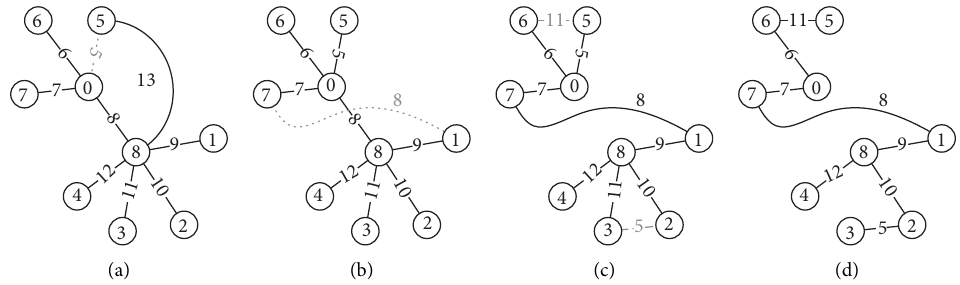
Figure 4: (a) A caterpillar with a strongly c-elegant labelling with [ 6 , 13 ] . (b) A caterpillar T with a strongly c-elegant labelling with [ 5 , 12 ] . (c) A left transformation L ( T ) of T . (d) A right transformation L ( T ) R of L ( T )